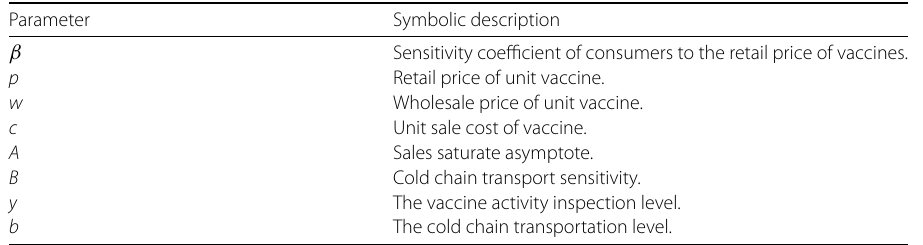
Table 1 The parameters description for system